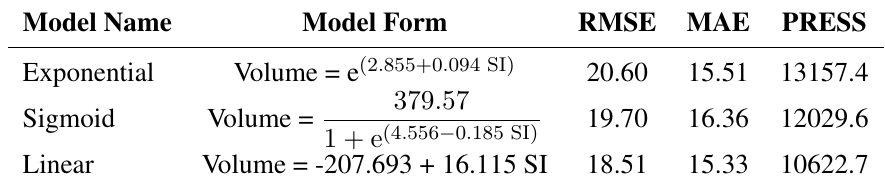
Table 4. Comparison of model fit statistics for exponential, sigmoid, and linear relationships between stand volume outside bark (m 3 ha − 1 ) and site index (m) at base age 25 based on leave-one-out cross validation, Root Mean Square Error (RMSE), Mean Absolute Error (MAE), and Predicted Residual Sums of Squares (PRESS).